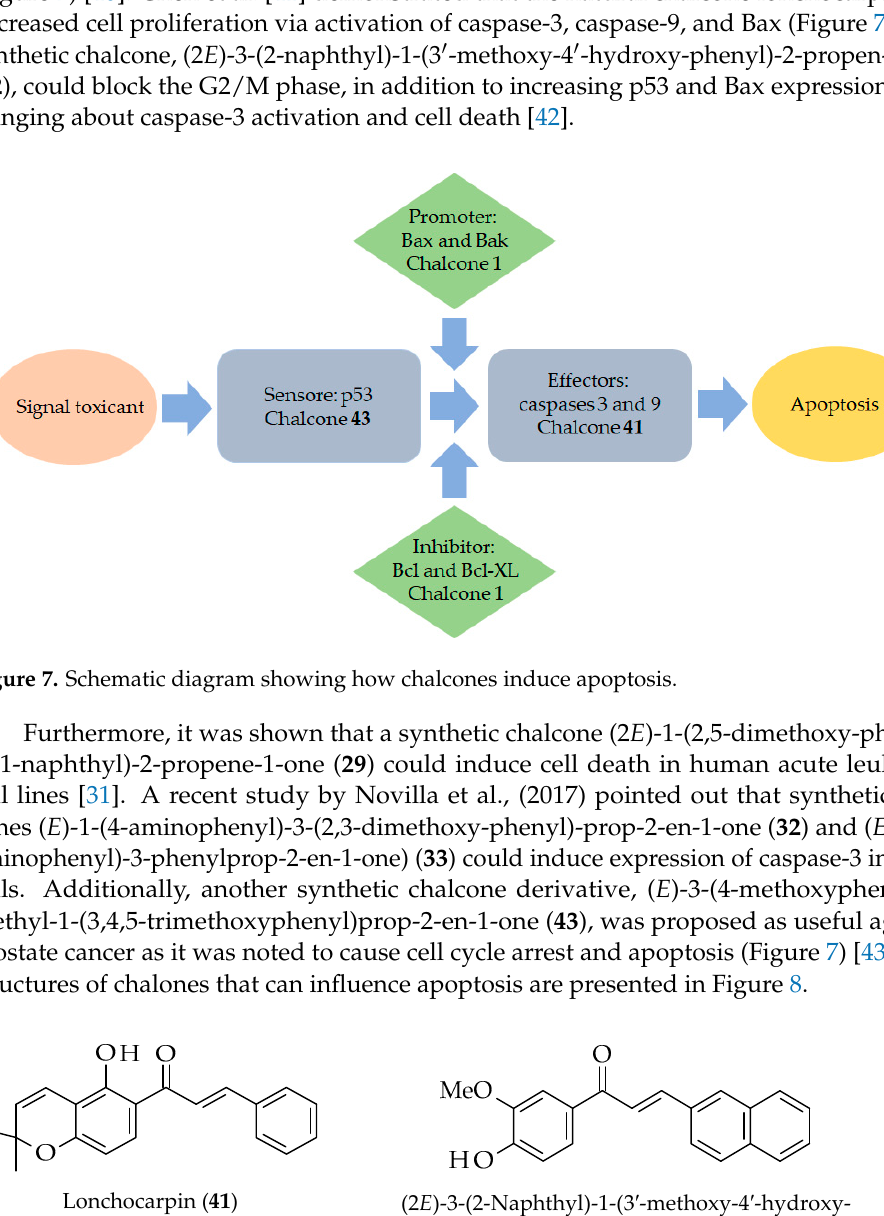
Figure 8. Structures of some chalcones that influence apoptosis.